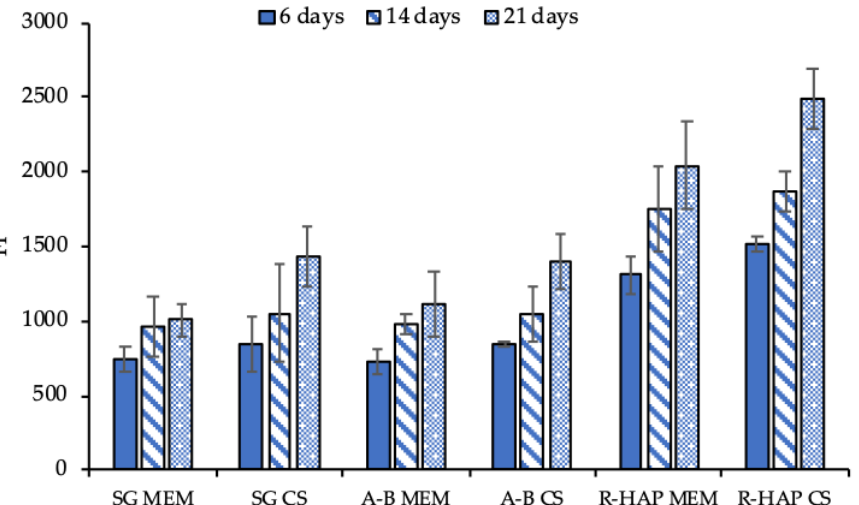
Figure 8. Viability (FI, fluorescence intensity) of hASCs grown onto the A-B and R-HAP parts of the tubular scaffold after 6, 14, and 21 days in culture with MEM (growth medium) and MEM supplemented with 3% w / w CS (mean values ± sd; n = 8). ANOVA one-way; Scheffé test ( p ≤ 0.05): 6